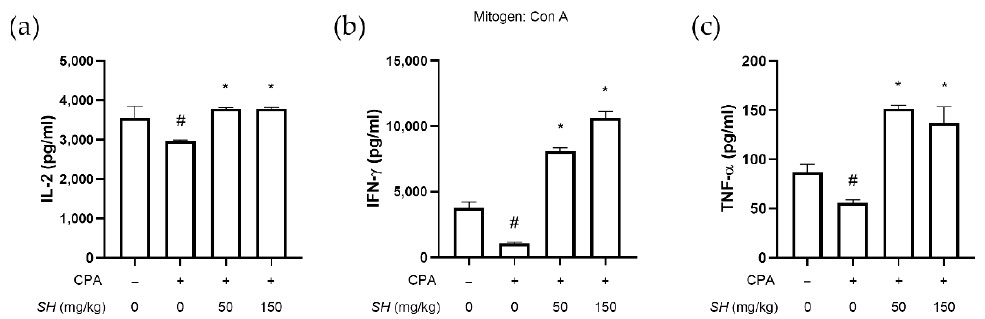
Figure 6. Effects of SH on cytokine expression in a CPA-induced immunosuppressed in vivo model. SH was orally administrated in BALB/c mice for 14 days. CPA was injected on days 14 and 16 to induce immunosuppression. After sacrifice, blood was collected, serum was separated, and cytokine expression of ( a ) IL-2, ( b ) IFN- γ and ( c ) TNF- α was measured using the ELISA method. # p < 0.05 vs. naïve mice, * p < 0.05 vs. CPA-injected mice. Results are displayed as mean ± SD of three or more separate experiments.